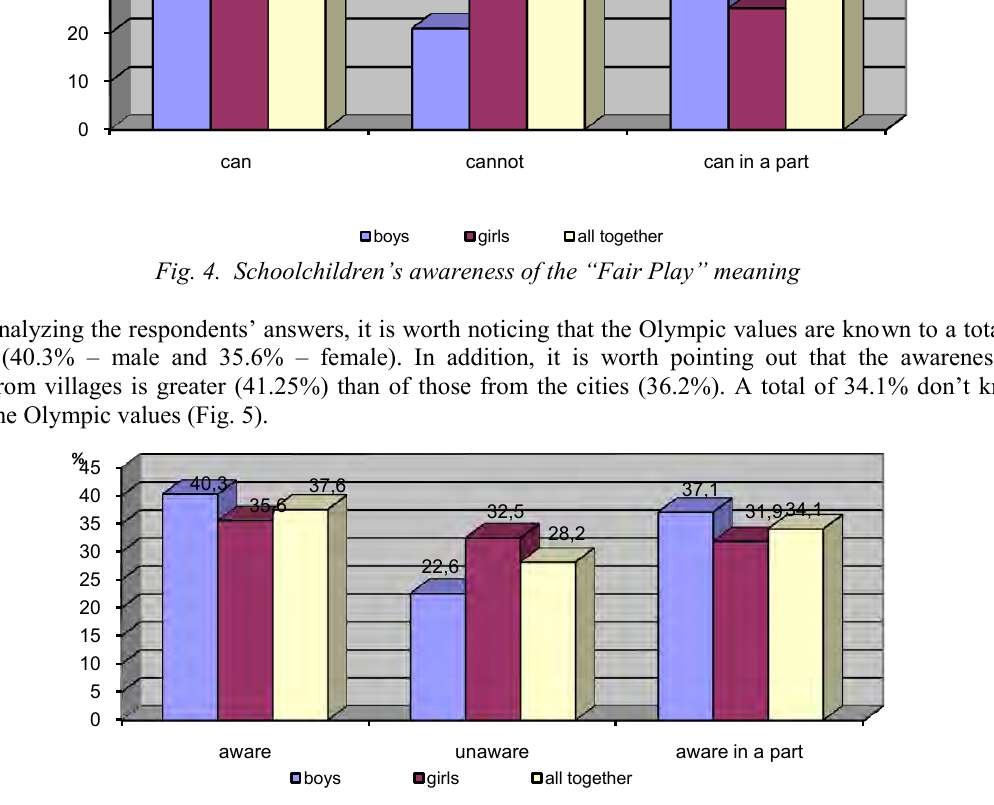
Fig. 5. Schoolchildren’s awareness of the subject of the Olympic